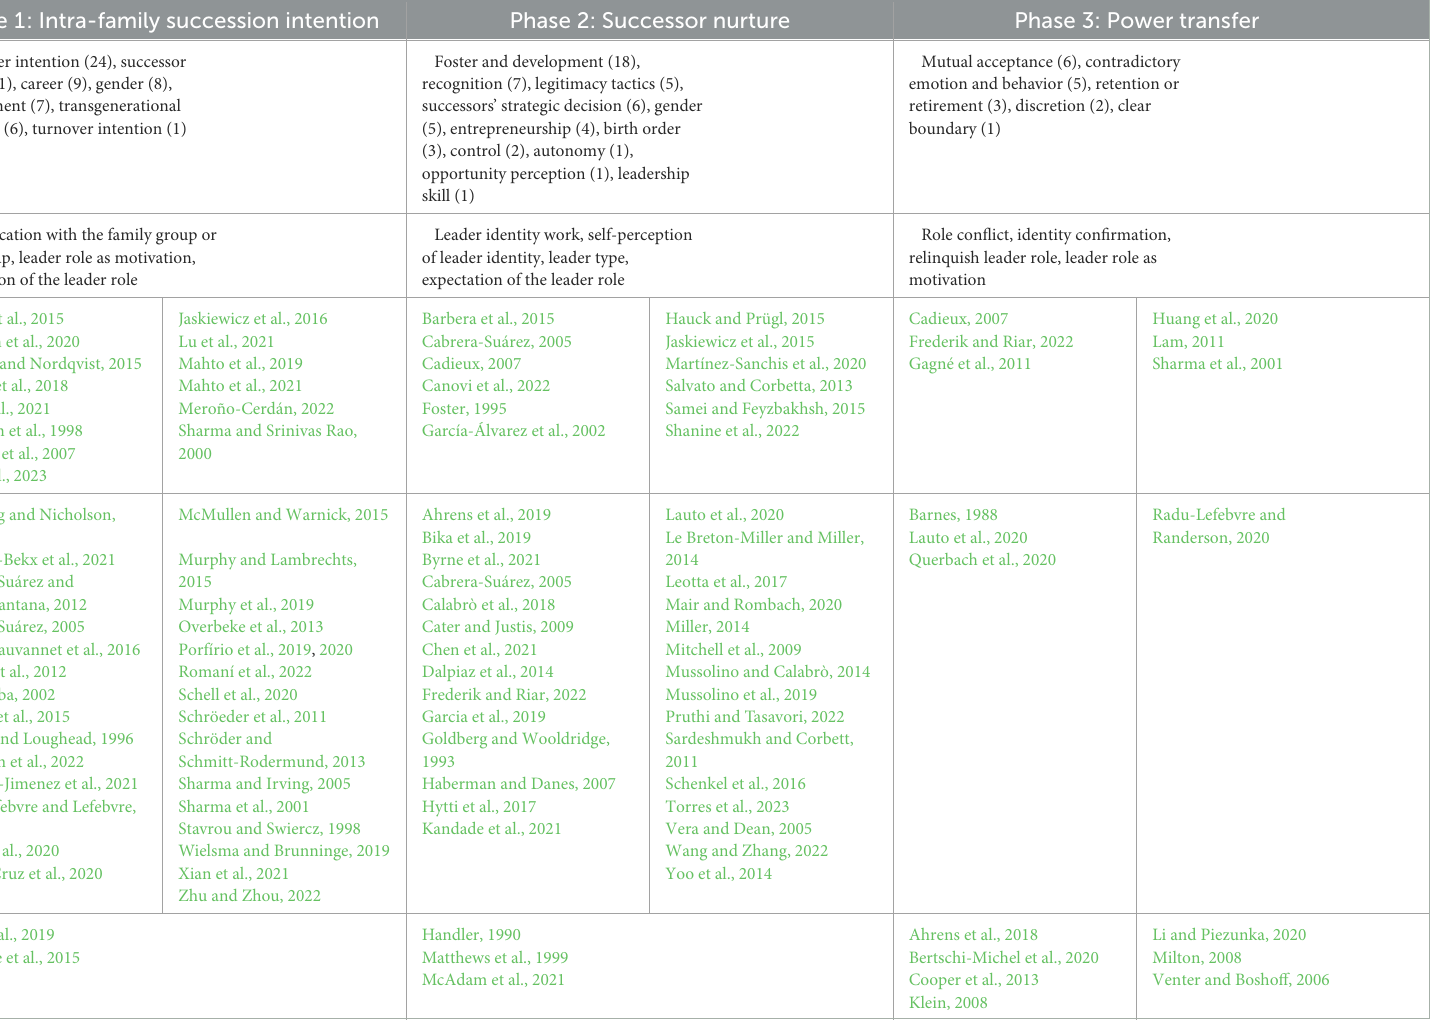
TABLE 3 Succession topic, identity concept, and categorization of sample article in three phases. Phase 1: Intra-family succession intention Phase 2: Successor